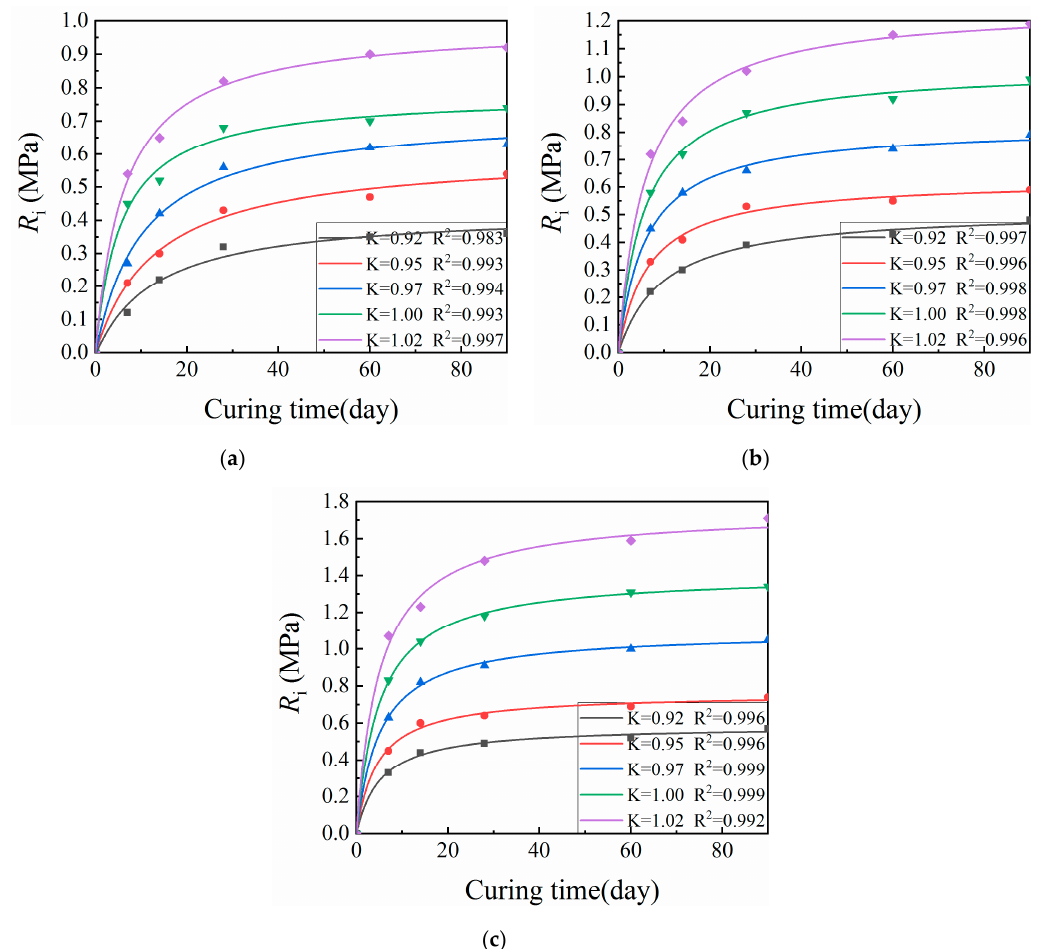
Figure 5. Relationship between age and splitting strength for cement improved loess: ( a ) cement dosage 3%; ( b ) cement dosage 4%; and ( c ) cement dosage 6%. K is the compaction coefficient of the specimen.